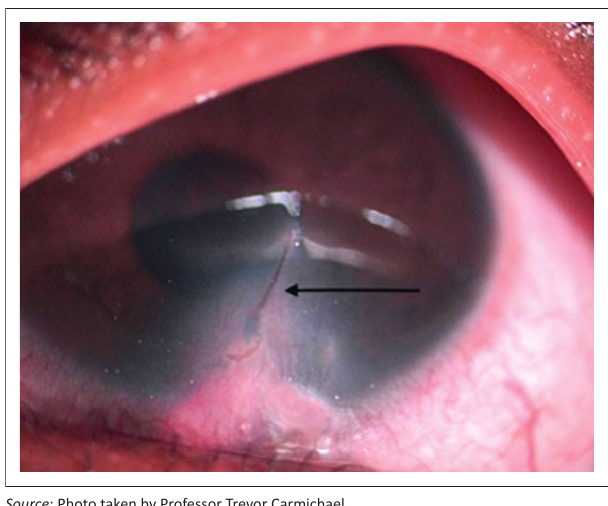
FIGURE 1: Retained bee stinger in the cornea (black arrow) with adjacent inflammatory limbal nodule and conjunctival inflammation.